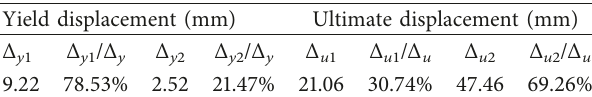
Table 6: Effect of unbonded reinforcement on yield displacement and ultimate